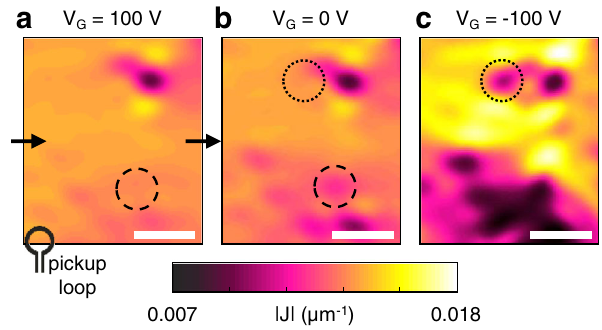
Fig. 1 Disorder and percolation in a mono-domain. Current density (magnitude, j J j ) images of a mono-domain region (sample H1), at various gate voltages, V G : 100 V ( a ), 0 V ( b ), and − 100 V ( c ). Reducing V G increases the inhomogeneity of the current fl ow, as additional patches of low current density appear (circles), and isolated patches cluster together ( c ). The arrows in panel a mark the overall direction of the current fl ow. The SQUID ’ s pickup loop, (diameter 1 µ m), is not drawn to scale. Scale bars, 15 μ